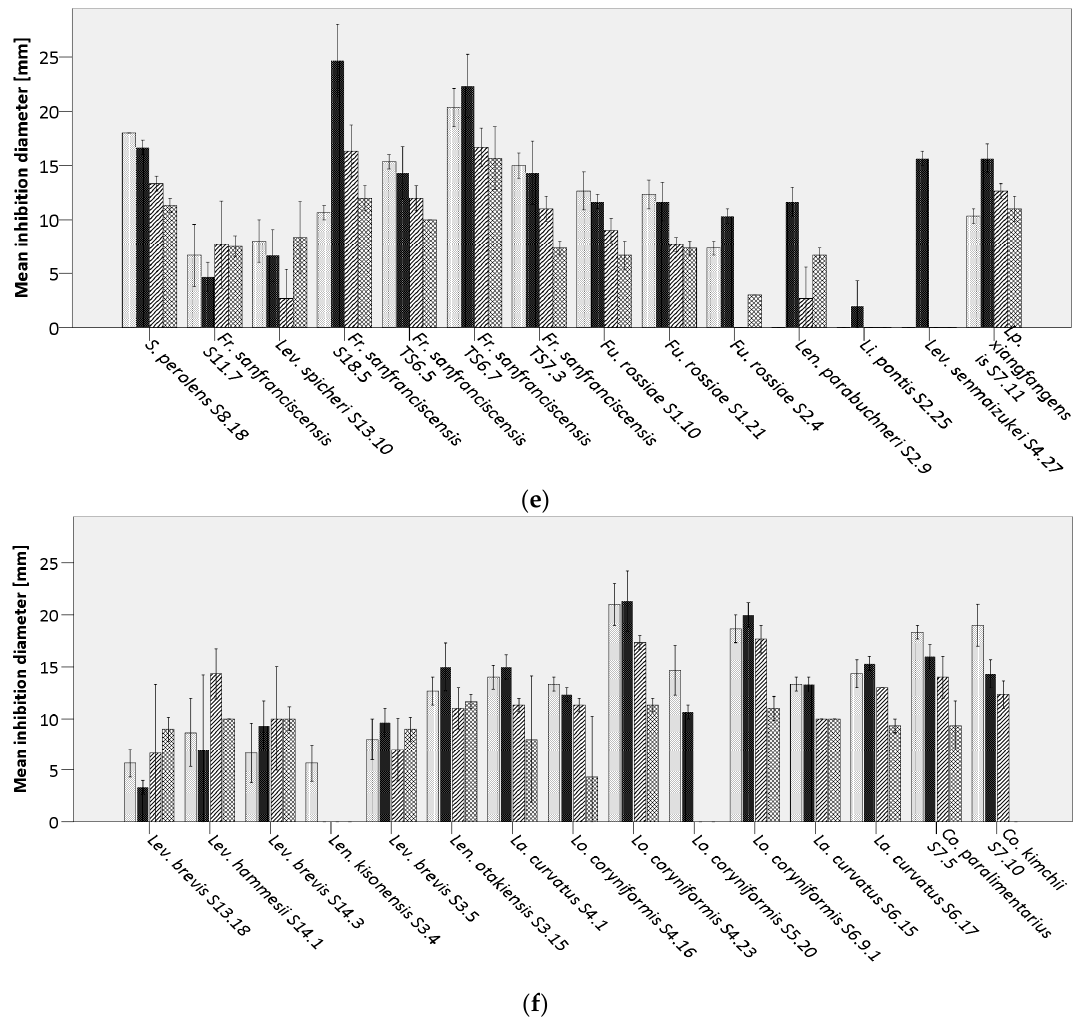
Figure 3. Average inhibition of analyzed lactic acid bacteria (LAB) against Bacillus cereus DSM31, B. licheniformis DSM13, B. subtilis LMG7135, and B. subtilis S15.20, by ( a ) Weissella spp., ( b ) Pediococcus spp., ( c ) Lacticaseibacillus paracasei , ( d ) Lactiplantibacillus plantarum , ( e , f ) further lactobacilli.